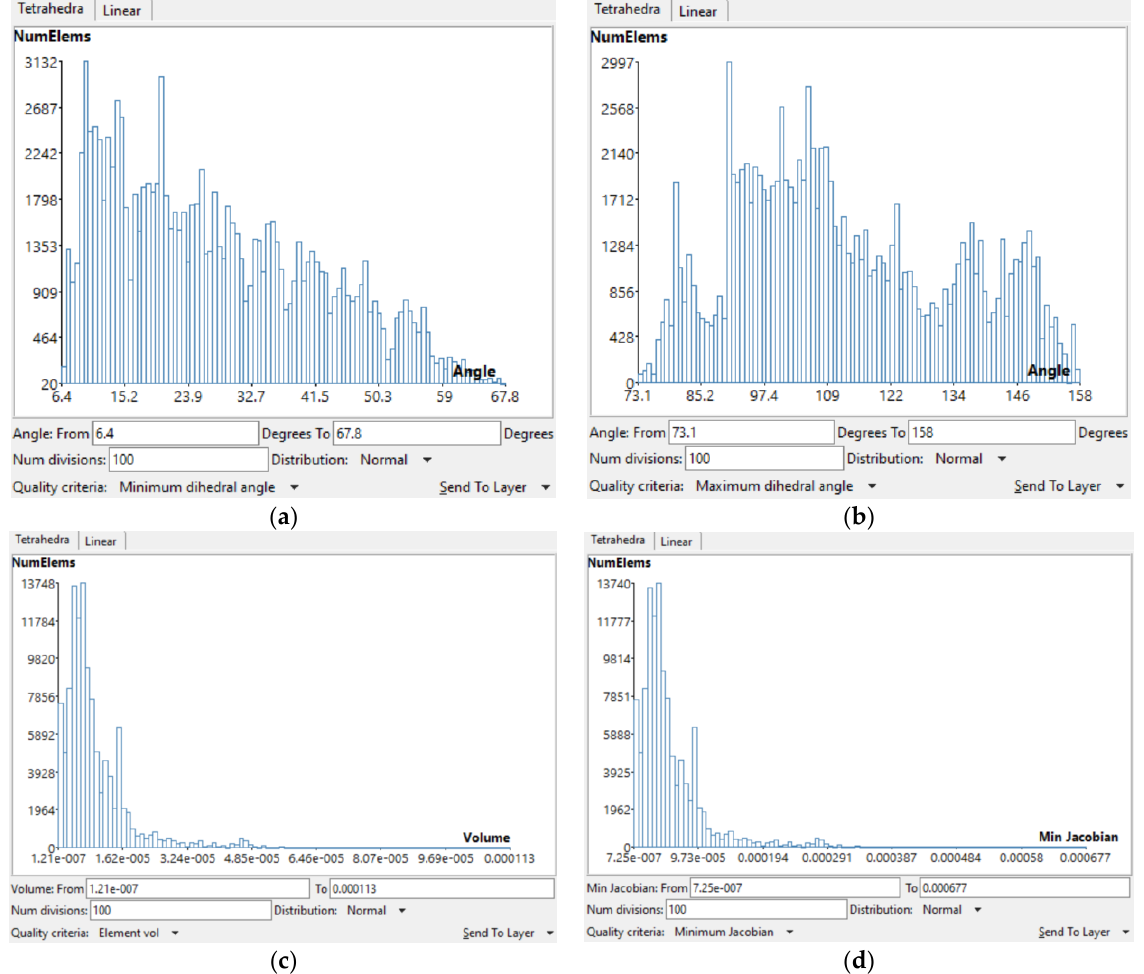
Figure 5. Properties of the used mesh: ( a ) minimum dihedral angle, ( b ) maximum dihedral angle, ( c ) element volume, and ( d ) minimum Jacobian.